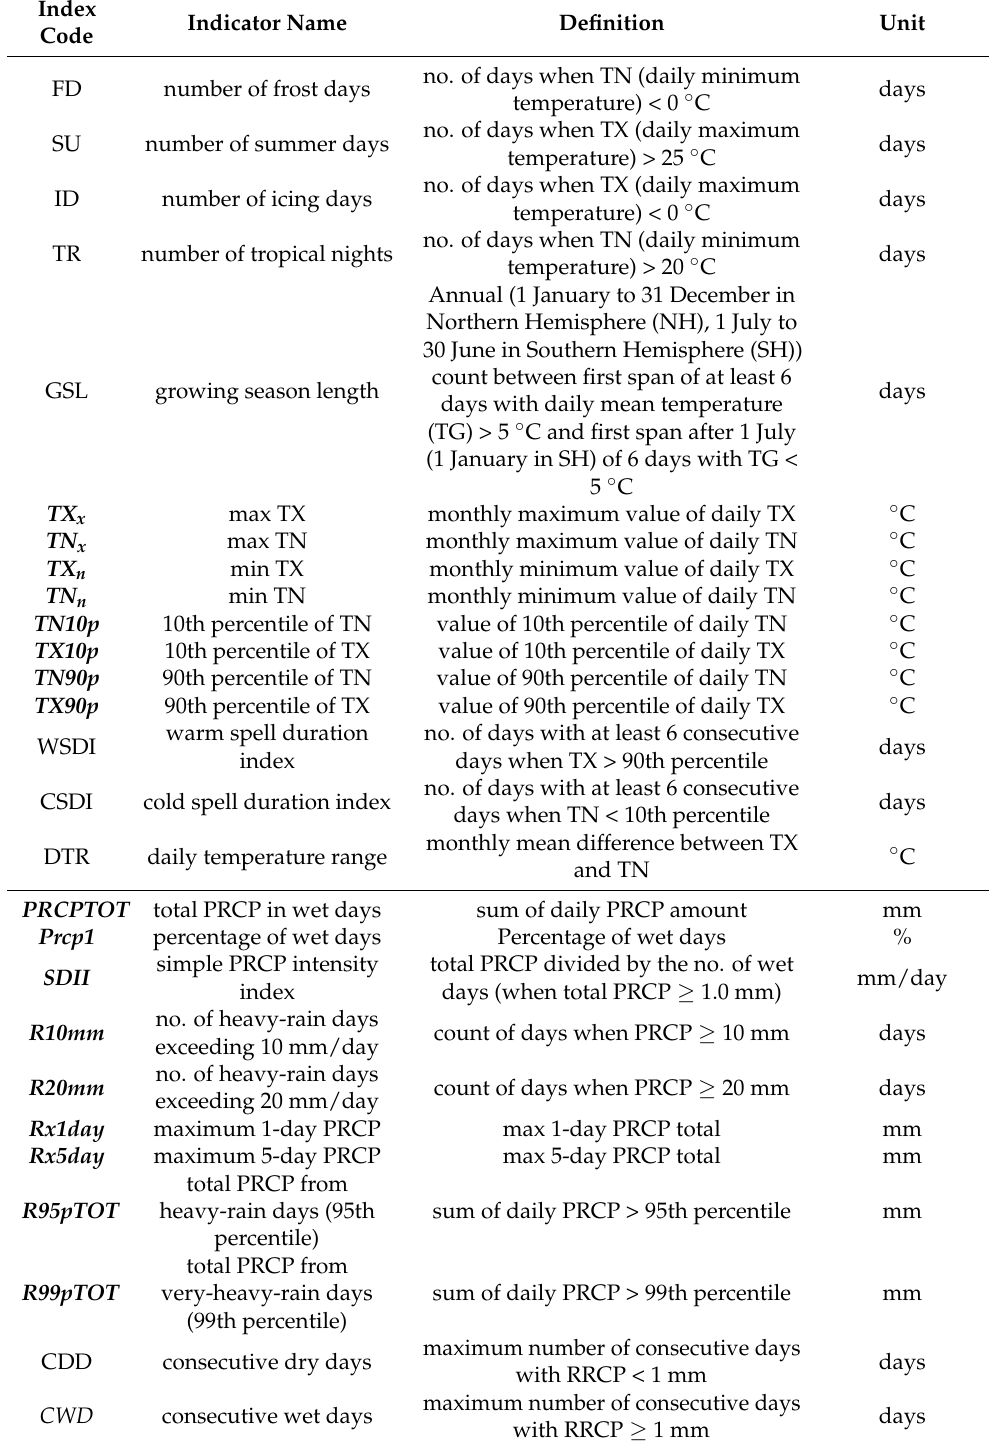
Table 2. Core indices of ETCCDI and additional user-defined indices. Bold/italic index denotes those used in this study. Here, PRCP = precipitation, TN = minimum temperature, and TX = maximum